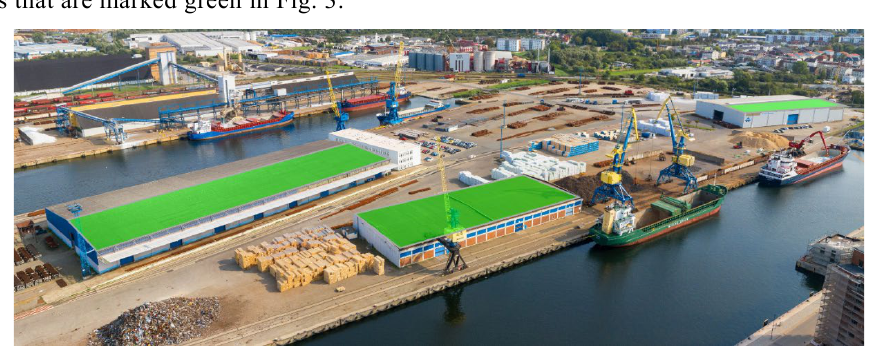
Fig. 3. Suitable facilities for photovoltaic plants [Compiled by the